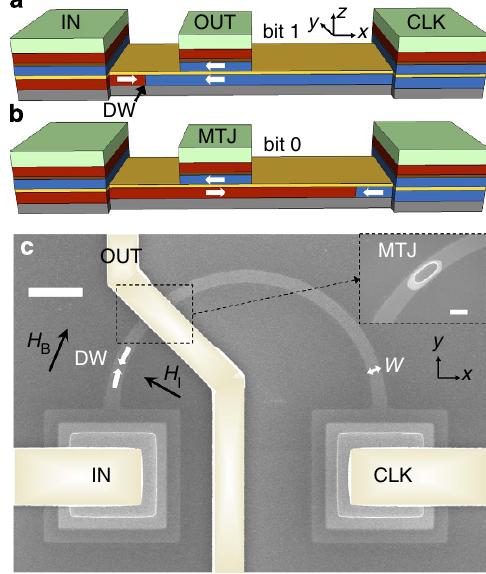
Figure 1 | Logic device cartoon and SEM. ( a ), Cartoon of the domain wall (DW) logic device, comprised of a magnetic wire with a DW and a magnetic tunnel junction (MTJ) to read out the DW position. Right-pointing magnetic moments are red and left-pointing are blue (grey represents Ta, brown Ru, and light green IrMn). Magnetization direction is also shown by the white arrows. The MgO tunnel barrier is shown in yellow. The device has three terminals, IN, CLK, and OUT. When the wire magnetization is parallel to the MTJ magnetization, the current at the OUT terminal is high, representing bit 1. ( b ), Cartoon showing the DW switched to the opposite side of the device, representing bit 0. ( c ), SEM image of a DW-Logic device prototype, showing the magnetic wire of width w ¼ 400nm and the MTJ under the center electrode with area 1 m m (cid:2) 400nm, also shown in the inset. Electrodes are coloured in light gold. The initial DW position is shown by the white arrows. The black arrows show the orientation of the initiali- zation field H I and bias field H B . Scale bars, 2 m m ( c ), 400nm ( c ,